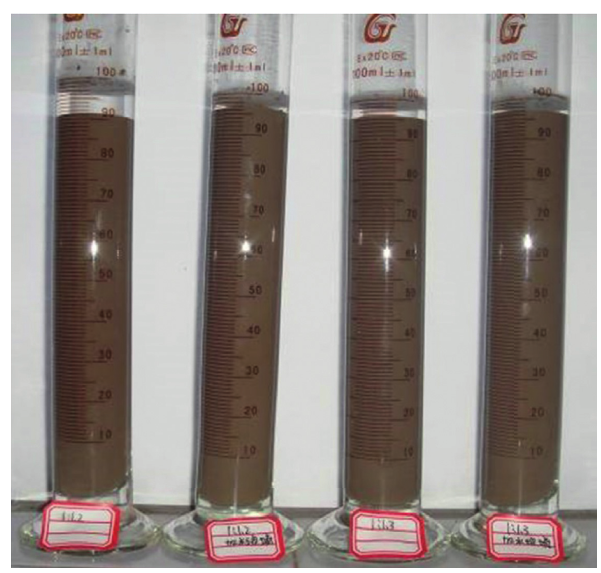
Figure 11: Process of slurry